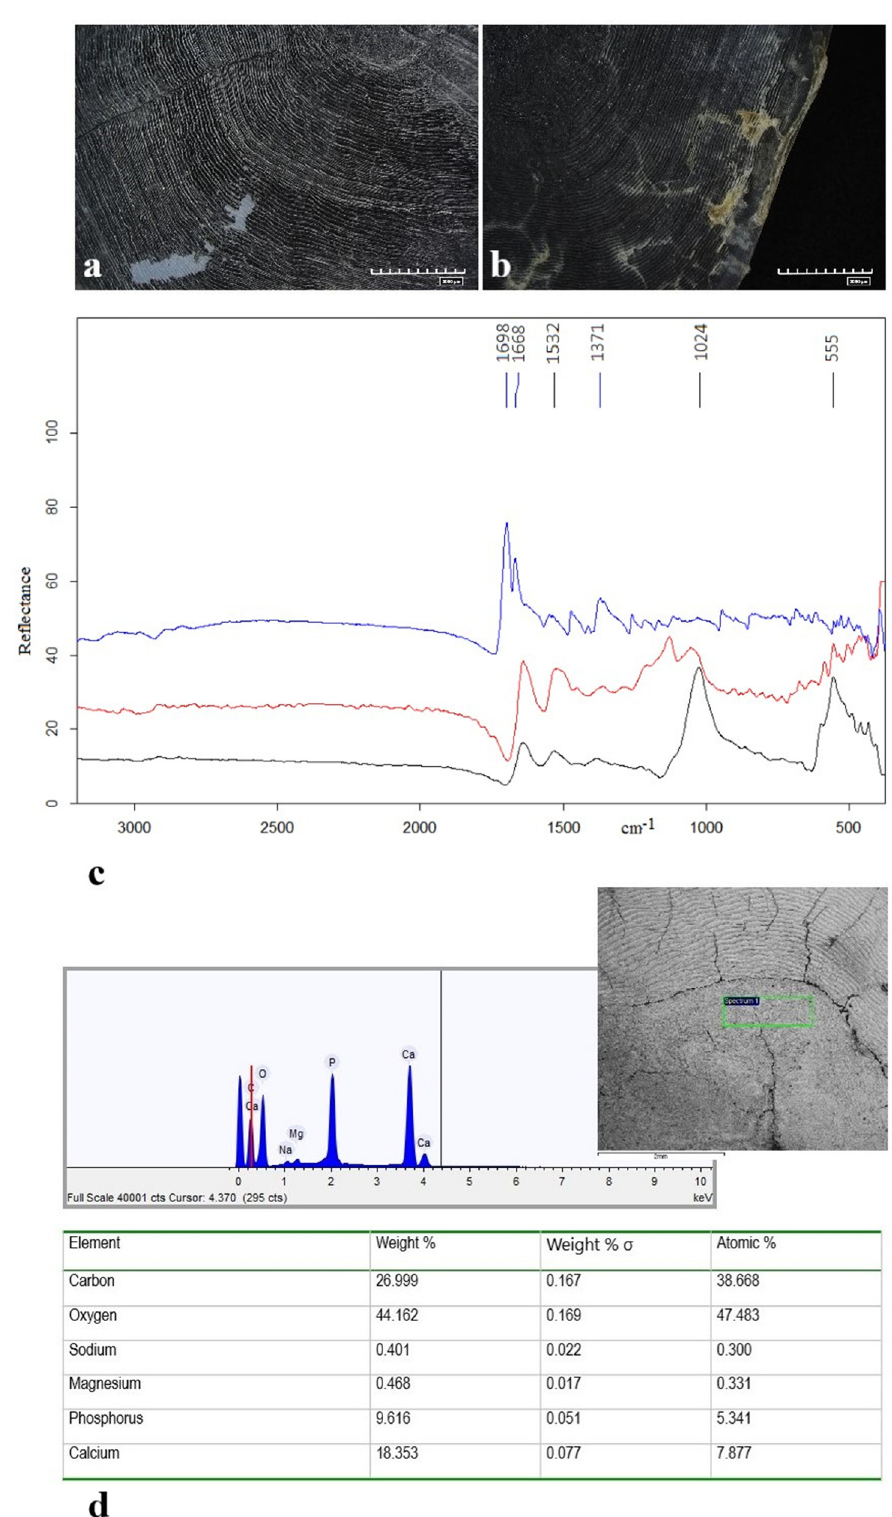
Figure 8: ( a ) , ( b ) Fish scale under the digital microscope and skin residues, ( c ) FTIR results – apatite, ( d ) SEM - EDX analysis, the ratio of phosphorus and calcium, fi sh scale ( FTIR spectra S. Nunziante Cesaro, photo A. Petrovi ć )